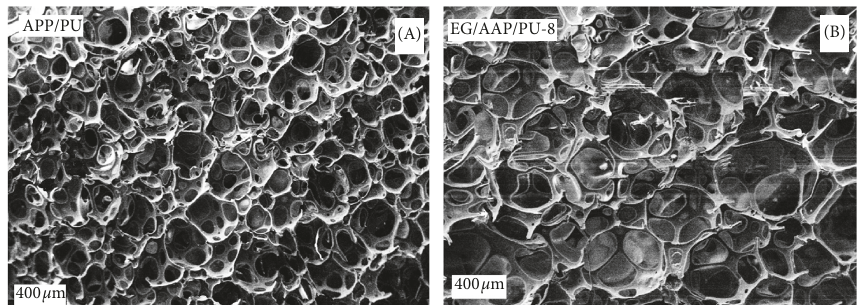
Figure 4: SEM micrograph of SPUF composites before